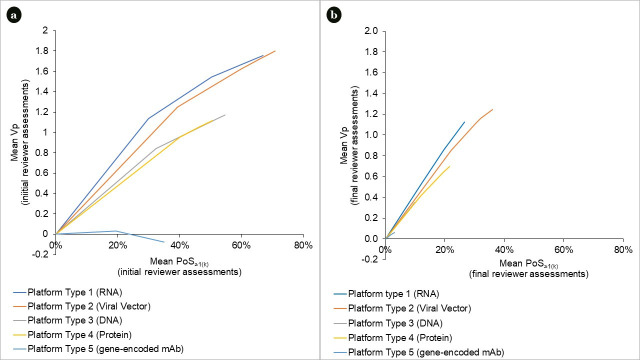
a. Portfolio value associated with probability of ≥1 project successfully developed per platform type (initial reviewer assessments). Mean POS≥1(k) and Vp estimates are calculated by running the optimization process under step 5 separately for each platform type k, as follows: maximizing Vp several times, each time incrementally increasing the number of projects (decision variables in the model) entering the portfolio, and repeating this process until all projects are added. b. Portfolio value associated with probability of ≥1 project successfully developed per platform type (final reviewer assessments). Mean POS≥1(k) and Vp estimates are calculated by running the optimization process under step 5 separately for each platform type k, as follows: maximizing Vp several times, each time incrementally increasing the number of projects (decision variables in the model) entering the portfolio, and repeating this process until all projects are added.